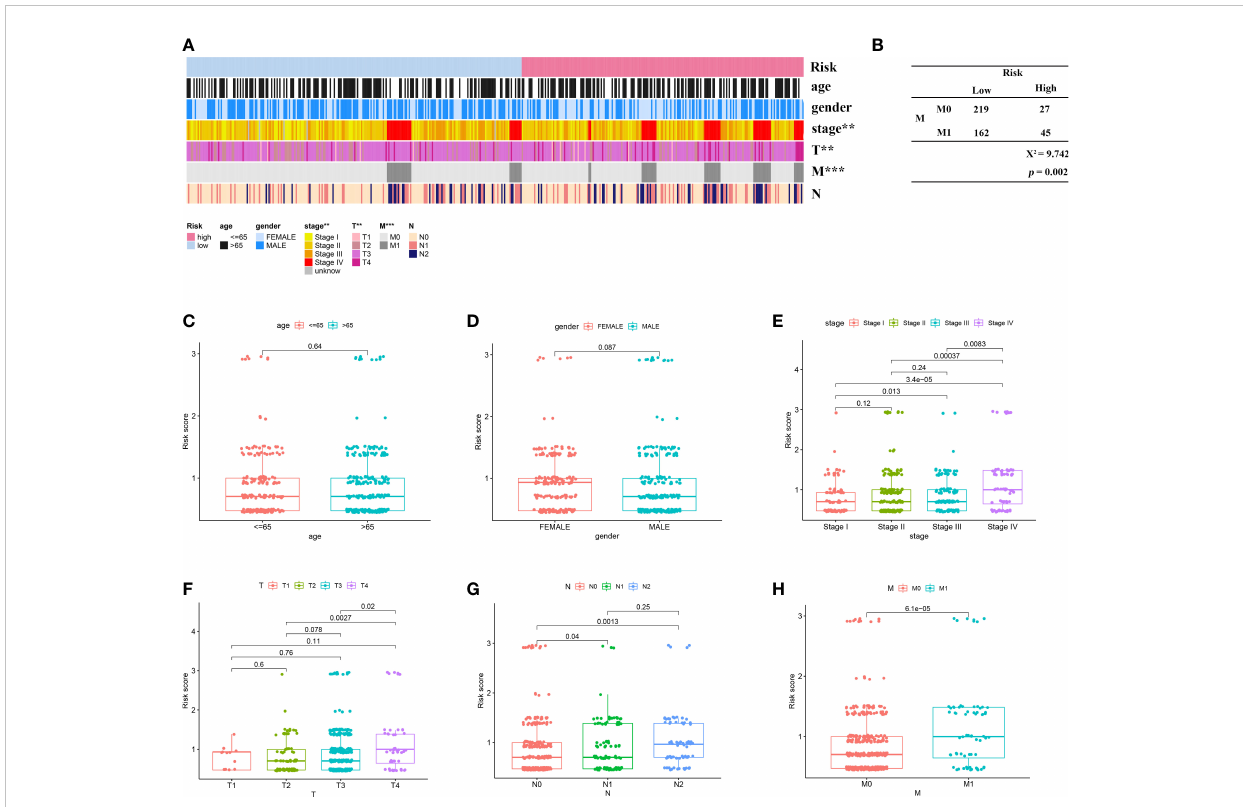
FIGURE 4 Correlation of risk signature with clinicopathological features. (A) Heat map reveals correlation between high and low risk score groupings and clinicopathological characteristics; (B) Chi-square test reveals signi fi cant correlation between risk score and metastasis; scatter plot indicates that (C) age and (D) gender are not correlated with risk score; scatter plot indicates signi fi cant correlation between (E) stage, (F) T, (G) N, and (H) M staging and risk score. ** p < 0.01; *** p <